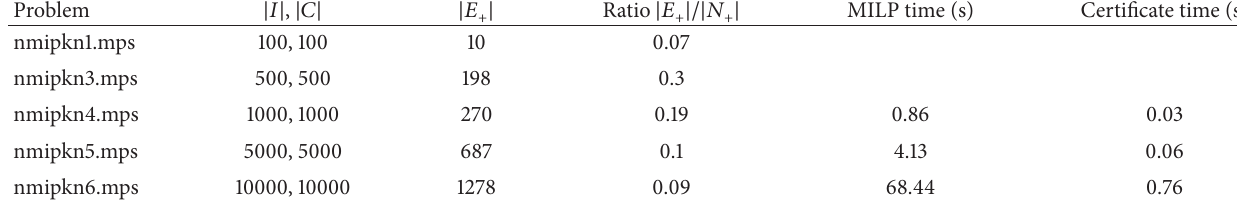
Table 4: Mixed integer knapsack problems.